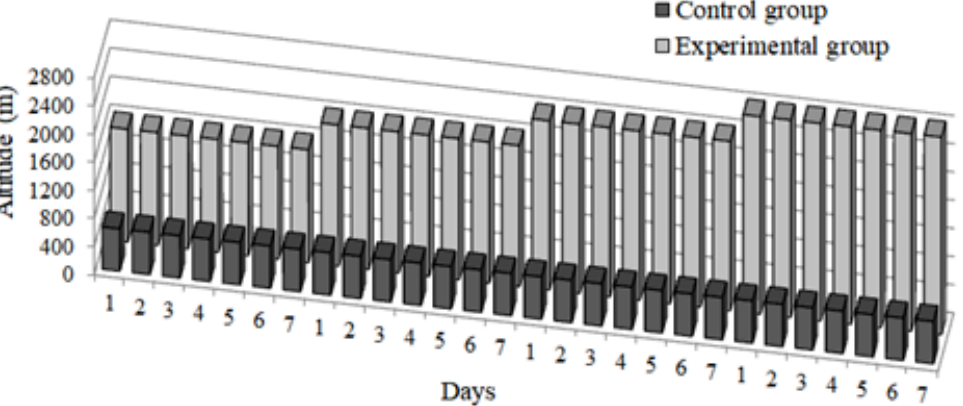
Figure 1. Experimental design. The simulated hypoxic exposure of the experimental group was eight hours every night. Table 1. Rower’s training program during experimental period Training session